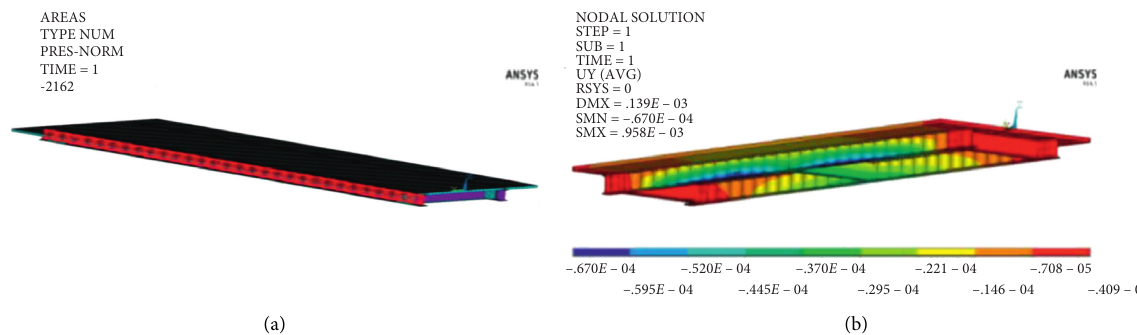
Figure 17: Wind load on the two I-shaped GFRP with corrugated webs-concrete hybrid girder. (a) Wind load action. (b) Displacement contour under wind load